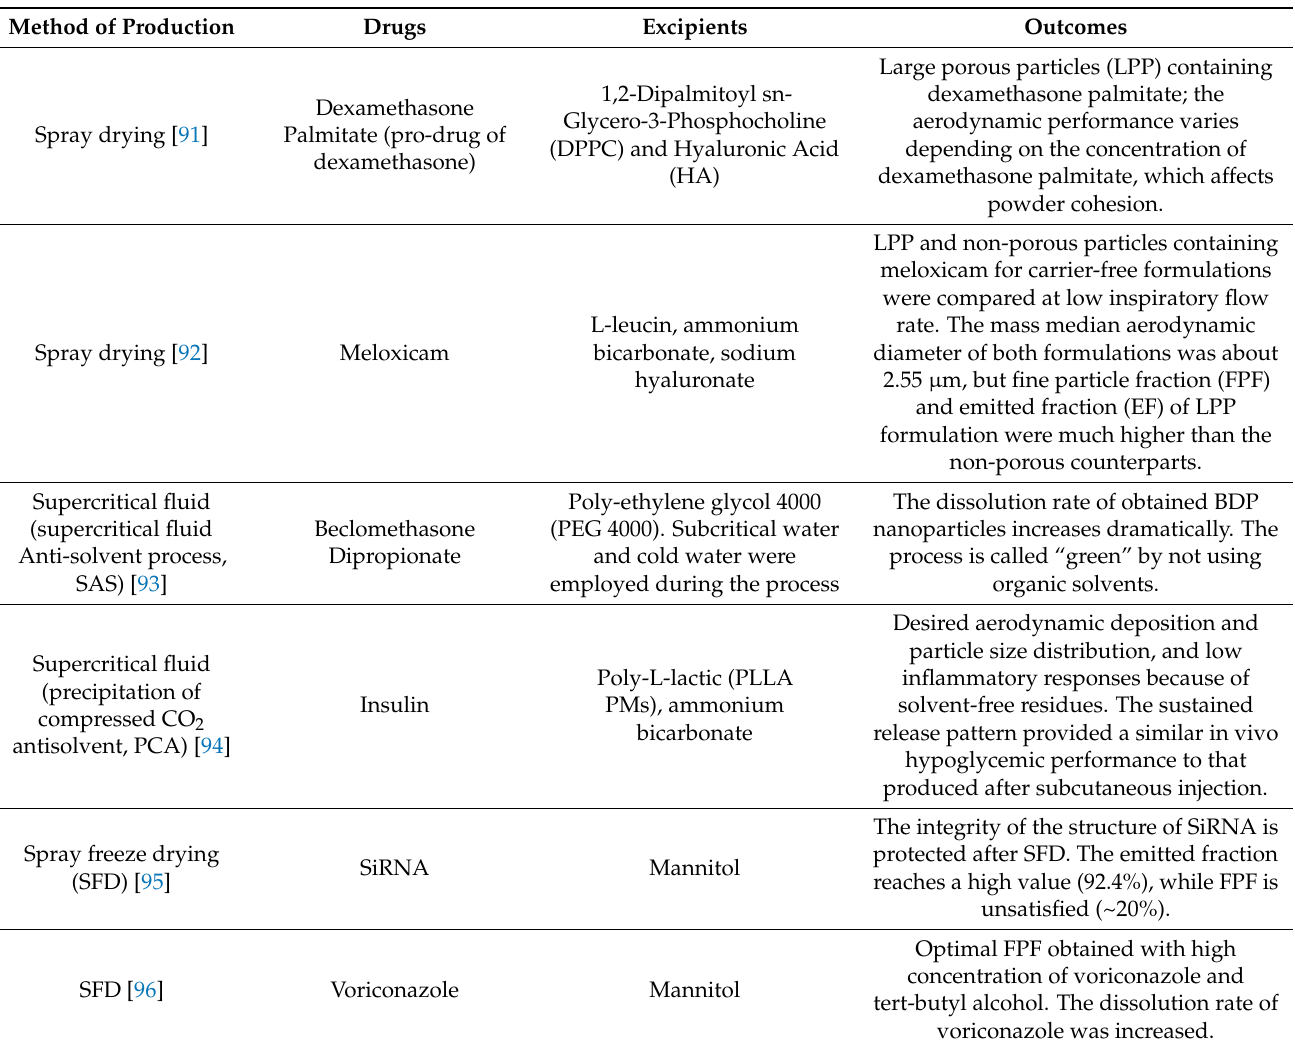
Table 4. Various porous particles generated by different powder technologies for pulmonary drug delivery